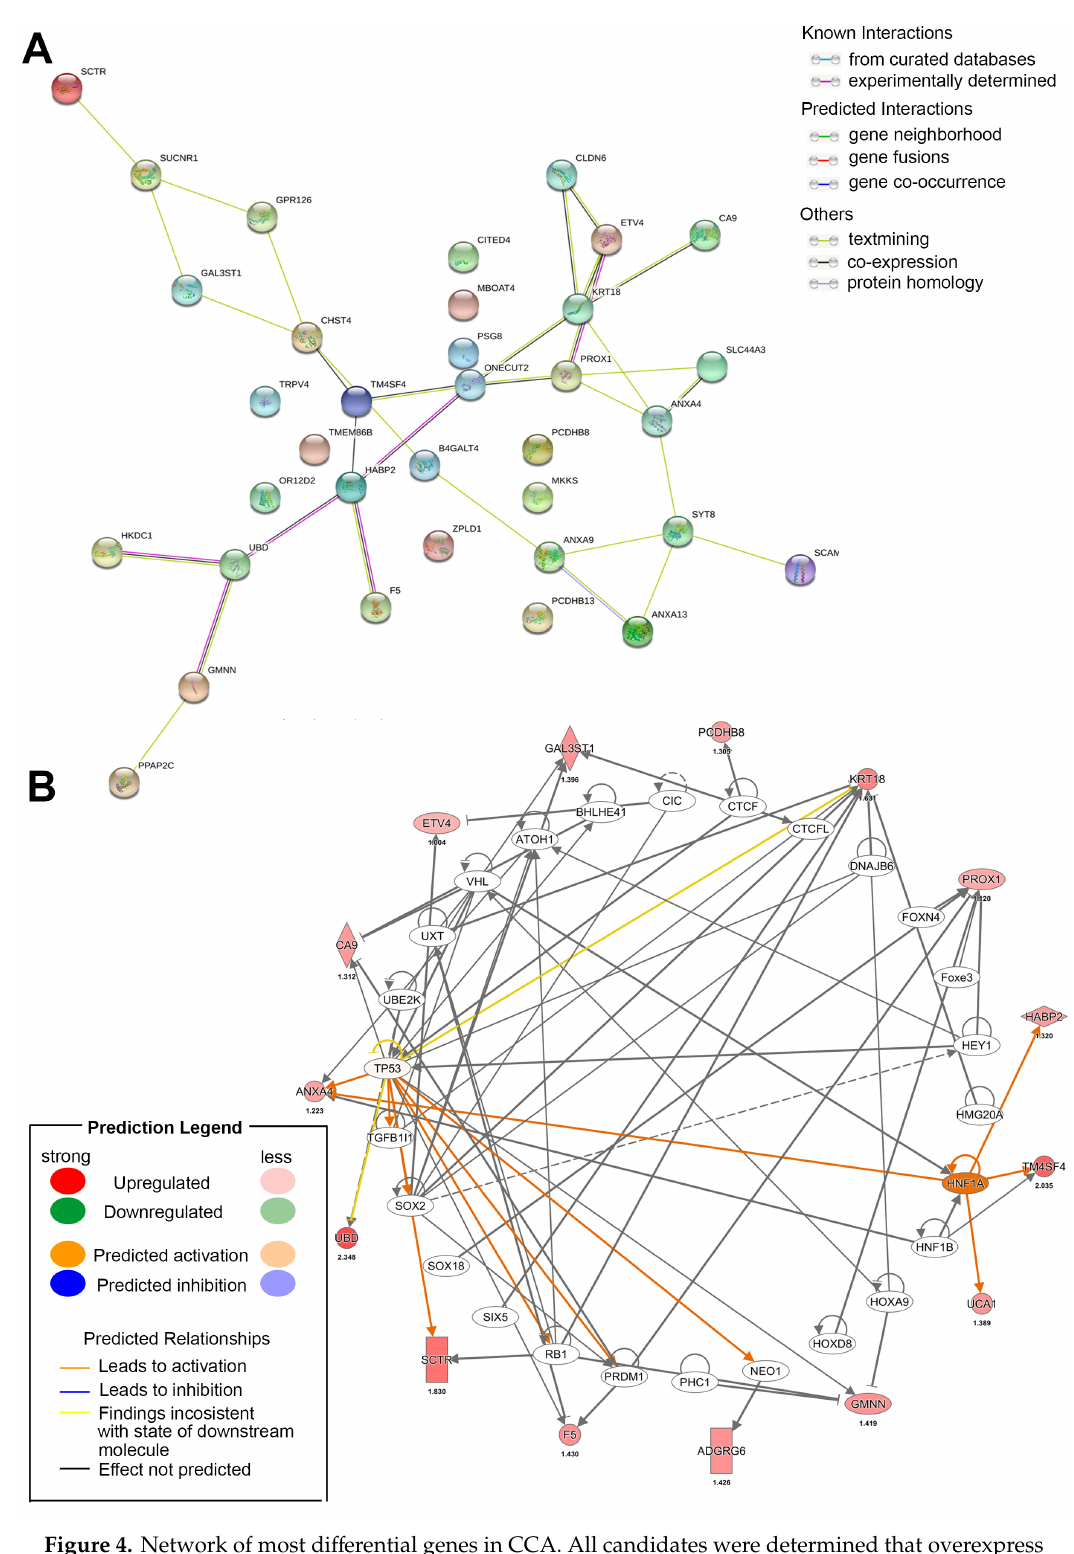
Figure 4. Network of most di ff erential genes in CCA. All candidates were determined that overexpress in CCA tumors compared with normal parts from gene expression profiling interactive analysis (GEPIA) website. ( A ) String and ( B ) ingenuity pathway analysis websites predict potential interactions, transcription factors and networks (p <